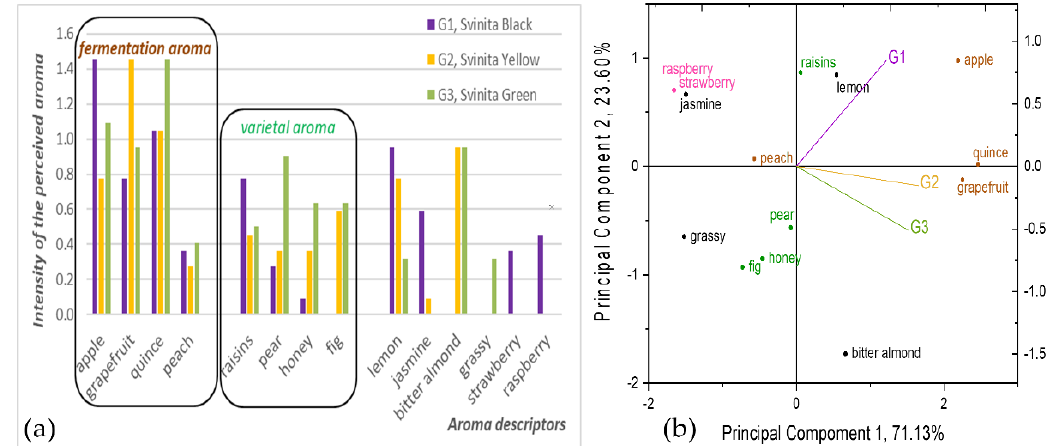
Figure 5. Frequency of aroma descriptor citations ( a ) and principal component analysis based on the frequency of aroma descriptor citations ( b ) for the beverages from fig varieties G1 – G3.